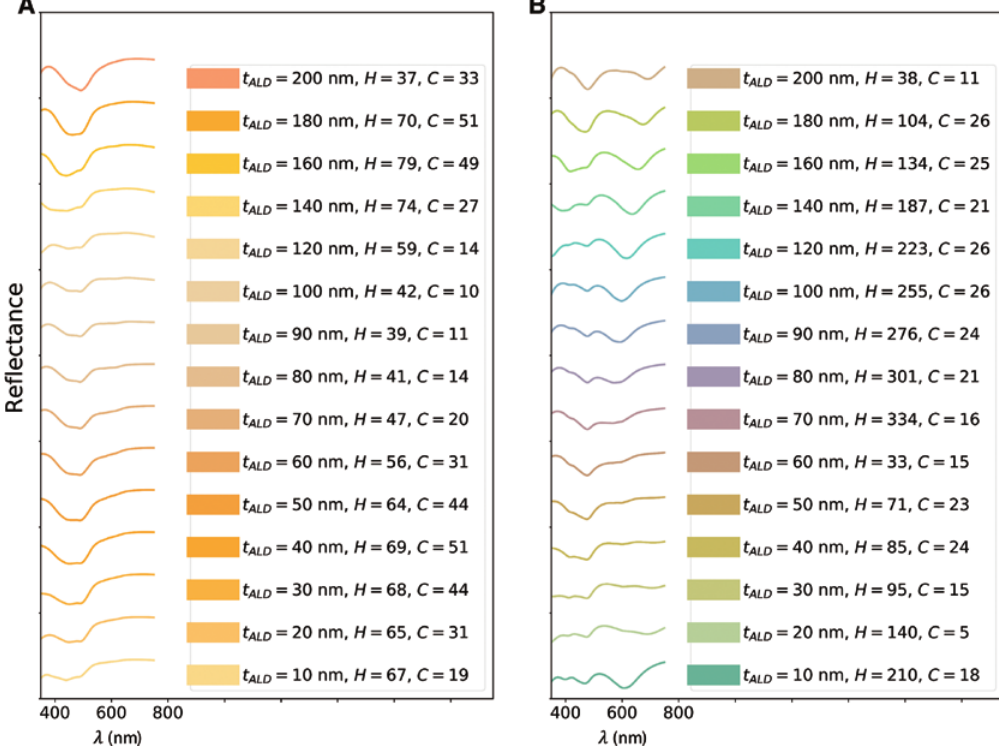
Figure 10: Reflectance spectra and colour evolution for increasing alumina thickness (two experimental trends). The simulation setup is R = 35 nm, A = 0 nm (flat surface), (A) D